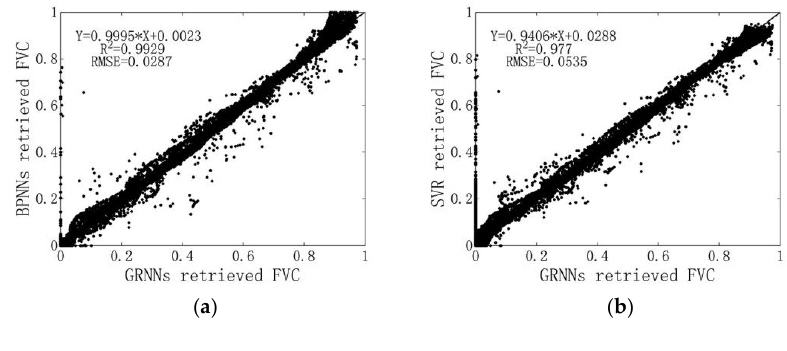
Table 2. The statistical performances of the four machine learning methods with 15,282 training